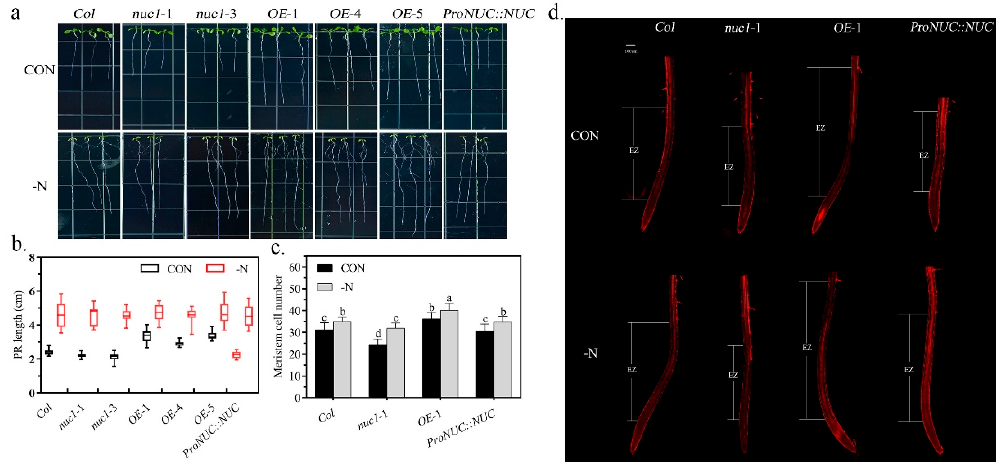
Figure 4. NUC overexpression promotes primary root elongation. ( a ): Root phenotype of 10-day-old seedlings, in which 4-day-old seedlings grown vertically under normal conditions were transplanted to media with (black box) and without (red box) nitrogen for 6 days. ( b ): Statistics on the primary root (PR) length of seedlings as in a ( n ≥ 15). The horizontal bars within boxes indicate medians. The tops and bottoms of boxes indicate upper and lower quartiles, respectively. The upper and lower whiskers represent maximum and minimum, respectively. ( c ): Root cortex meristematic cell number of 5-day-old seedlings, in which 3-day-old seedlings grown vertically under normal conditions were transplanted to media with (control, CON) and without (N deficiency, -N) nitrogen for 2 days. The number of cortex cells in a single file extending from the quiescent center up to elongated cells was counted. Values are means ± SD ( n = 10). Different letters indicate significant difference between treatments according to Duncan’s multiple range test at p < 0.05. ( d ): The elongation zone (EZ) in root tips. Confocal images of root tips stained with propidium iodide.